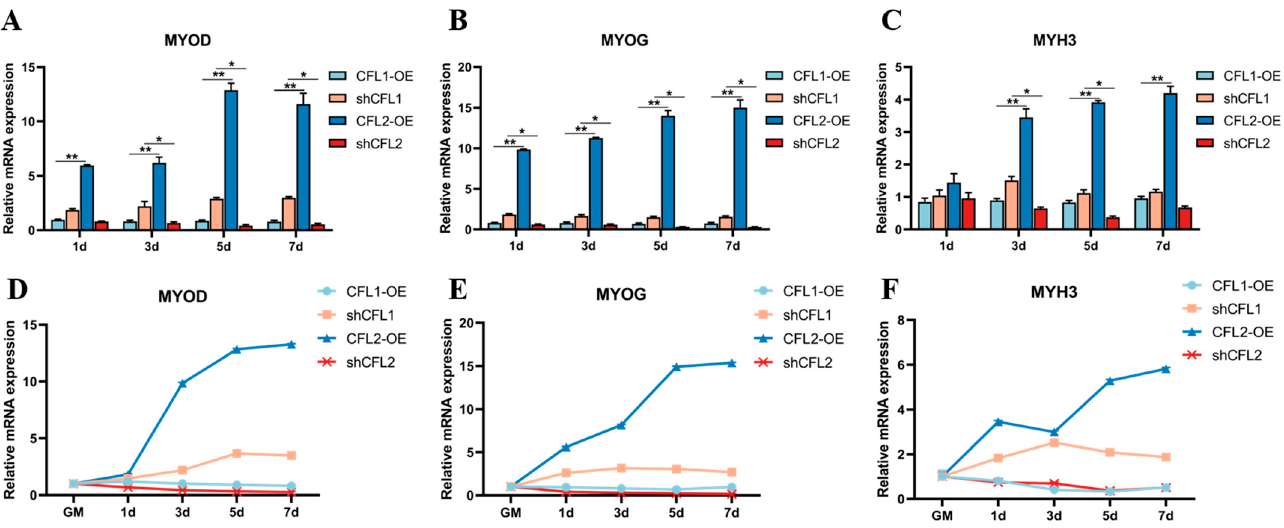
Figure 6. Functional comparison of CFL1 and CFL2 genes on the differentiation of PBMs. Overexpression vectors (CFL1-OE and CFL2-OE) and interference vectors (shCFL1-2 and shCFL2-1) of CFL1 and CFL2 genes were transfected into PBMs and induced for 1, 3, 5, 7 days by 2% horse serum. Then, the relative expression of marker genes MYOD, MYOG, and MYH3 were detected by qRT-PCR, transfected empty vector of overexpression or interference as negative control ( A – C ). Expression trends of myogenesis factors were detected by qRT-PCR, and the expression levels of four vectors in GM were considered as 1 ( D – F ). The mRNA expression levels of MYOD, MYOG, and MYH3 were normalized to GAPDH. Data are means ± SE of n = 3 independent experiments, each performed in triplicate. * , p < 0.05 and ** , p < 0.01, two-tailed t-test. GM, growth medium.